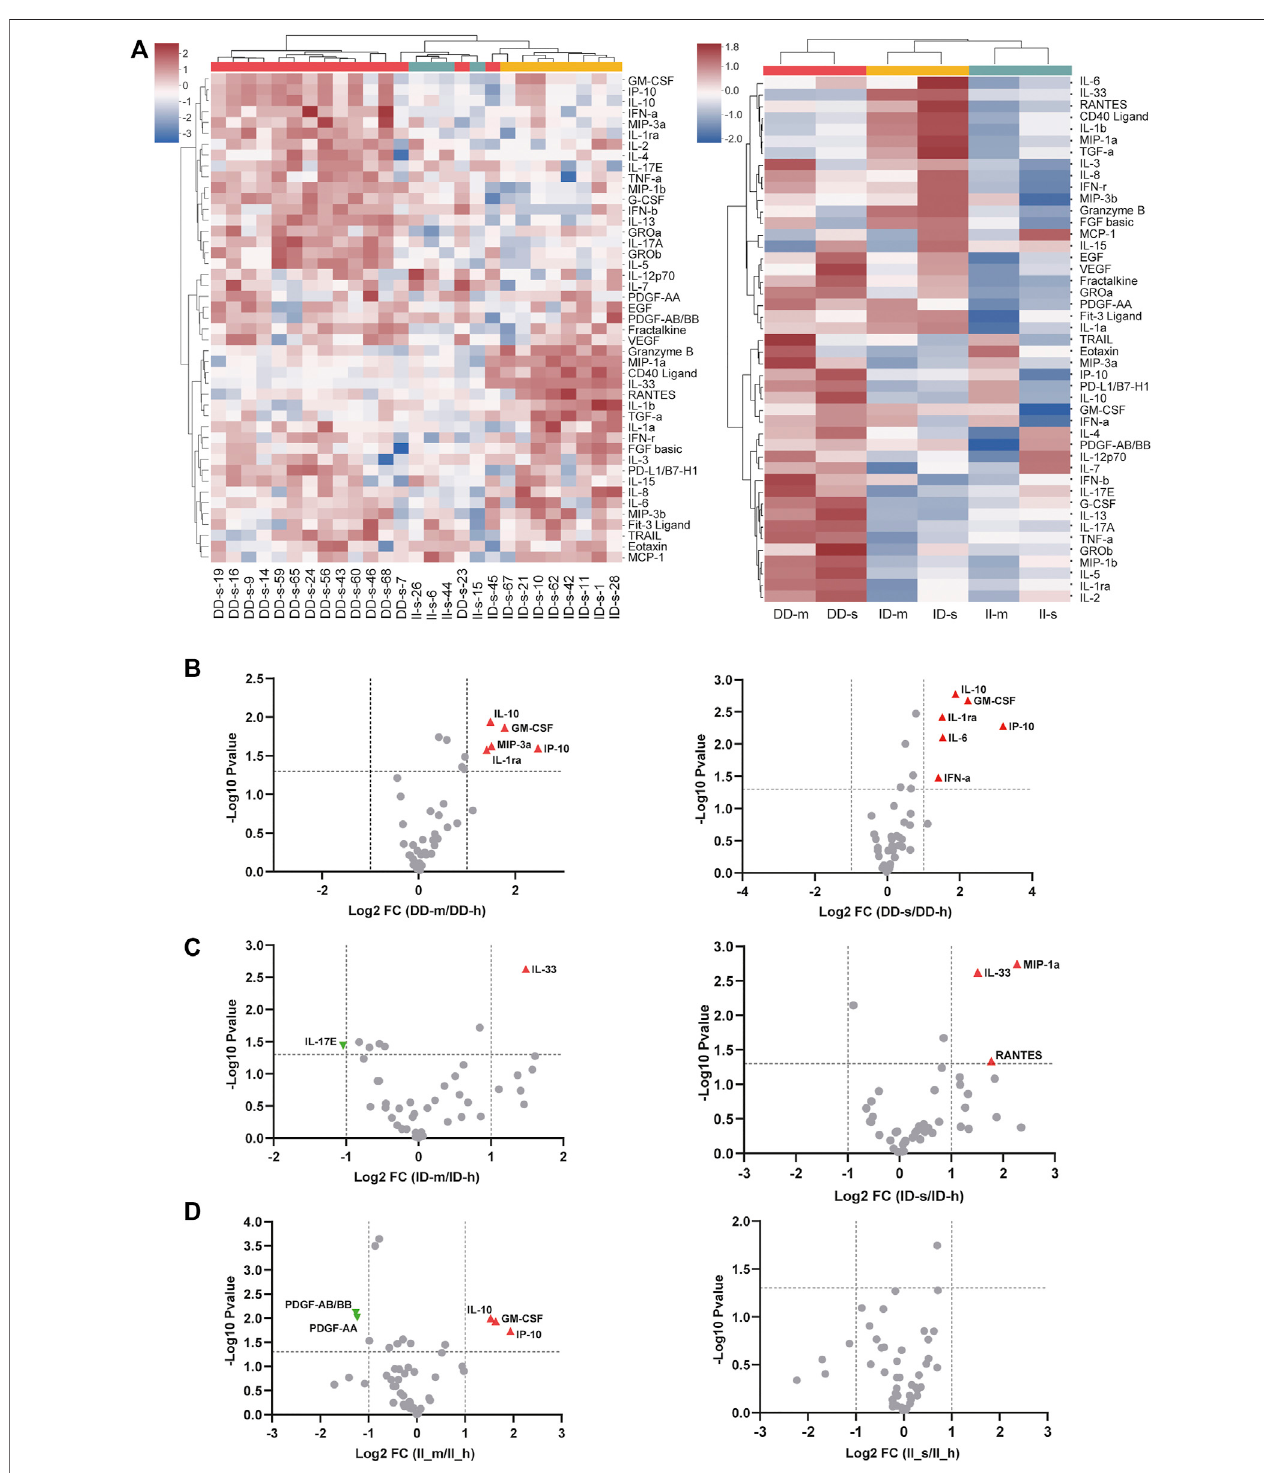
FIGURE2| Cytokines and chemokinesinCOVID-19patients withmild and severe symptoms inHubei Province. (A) Thepatientsweregrouped according toACE DD,ID,and IIgenotypes. Each genotype containedtwosubgroups basedondifferentprogressionsofpneumonia. Healthy,mild,and severepatients are indicatedash, m, and s, respectively. We removed the outliers and replaced them with the median of other values in the same subgroups. The cytokines of the mild and severe subgroups were divided by the healthy subgroups. The calculated results were averaged and then we took the logarithm (log 2 ) of the results in order to unify the dimension. (B – D) To obtain the aforementioned statistical results, we calculated the negative logarithm (log 10 ) of the p value for each subgroup to indicate the signi fi cance of the differences between two groups of data ( − log 10 ( p value) ≥ 1.30103 means signi fi cant). Volcano plots were shown to characterize the cytokine differences between the patients and the healthy groups in different ACE